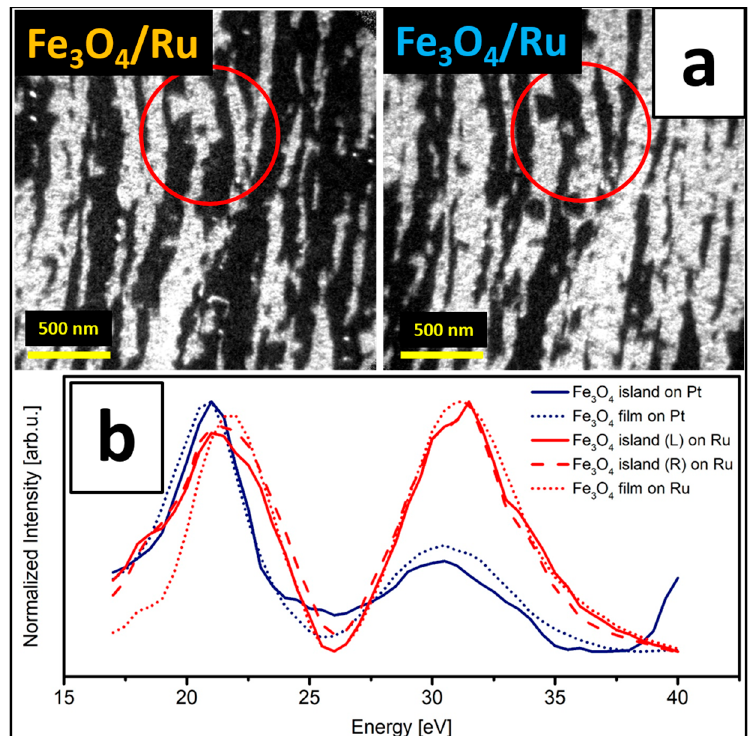
Figure 7. DF-LEEM images of the Fe 3 O 4 (111) film grown on Ru(0001) by ~7.6 MLs Fe deposition (total dose) under UHV at RT and oxidation in 1 × 10 − 6 mbar O 2 at 900 K ( a ) (red circles mark the same sample position; imaging energy: 26 eV), obtained by mapping the diffraction spots analogous to those marked in colors in Figure 6d; ( b ) shows LEEM-IV curves obtained for Fe 3 O 4 islands and multilayer films on Pt(111) and Ru(0001).